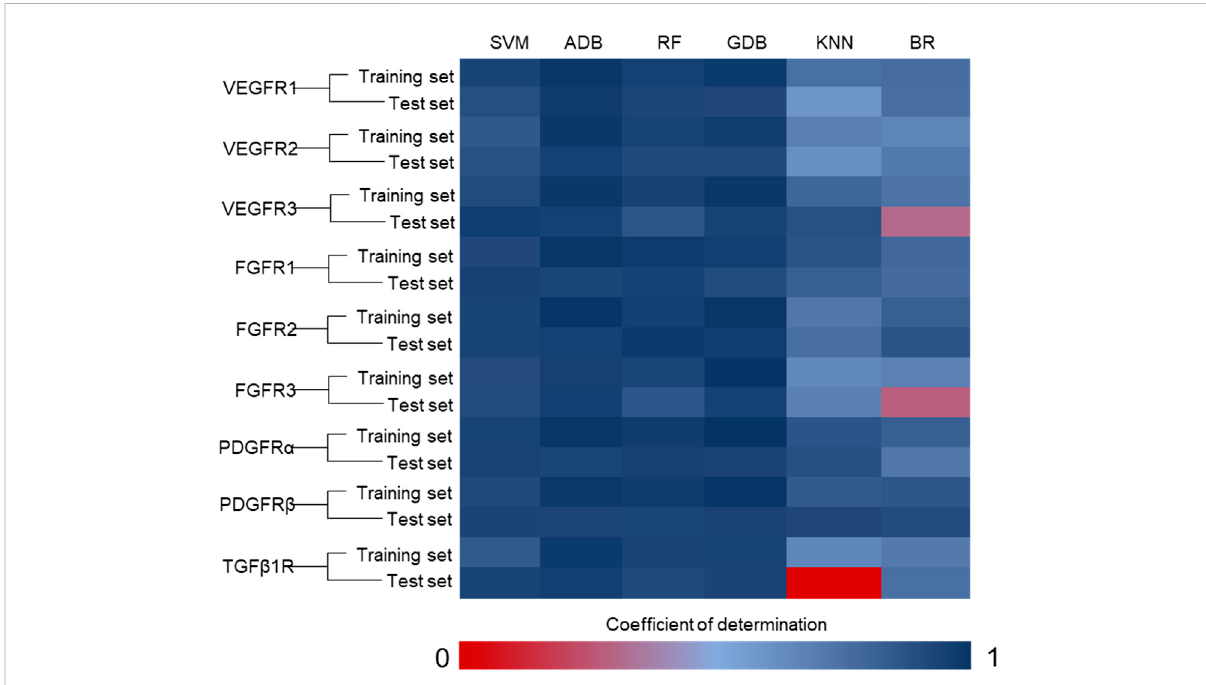
FIGURE 2 Coef fi cient of determination of themachine learning model. (SVM: support vector machine; ADB: AdaBoost; RF: random forest; GDB: gradient boosting; KNN: K-nearest neighbor; BR: Bayesian ridge) The integrated algorithms, such as ADB, RF and GDB, performed better than the single algorithm,andthedeterminationcoef fi cientsofboththetraining setandthetestsetweregreaterthan0.85.However,duetothelimitationofligand data, the cross-validation results of these models are poor. This implies that these machine learning models are over fi tting. These models will have poor accuracy in predicting unknown ligands, so we need to combine the results of virtual screening for selection. In addition, experimental data should be used to reduce the false positive rate of the